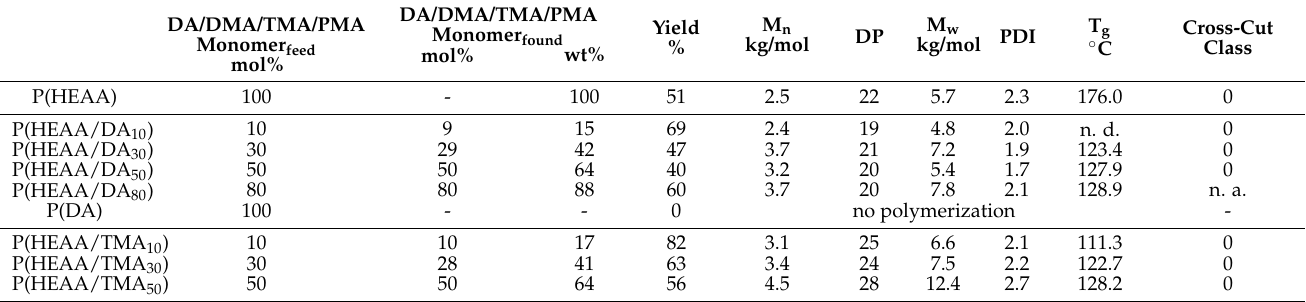
Table 1. Experimental data of the synthesized acrylamide